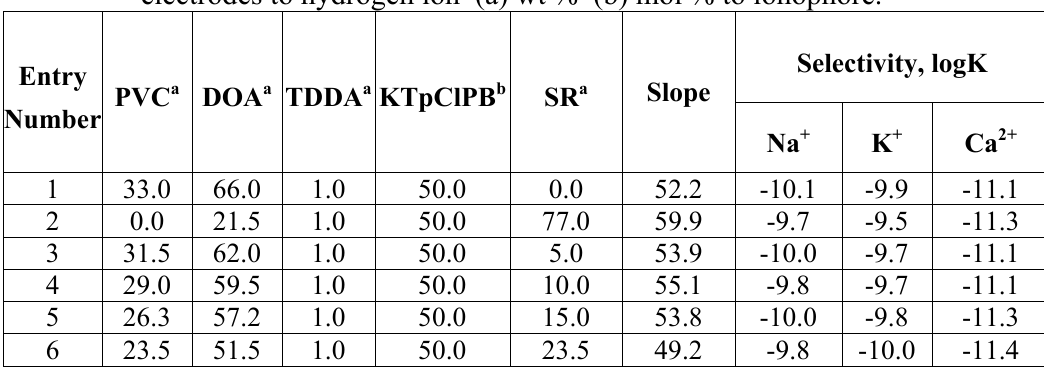
Table 1. Composition and electrochemical characteristics of